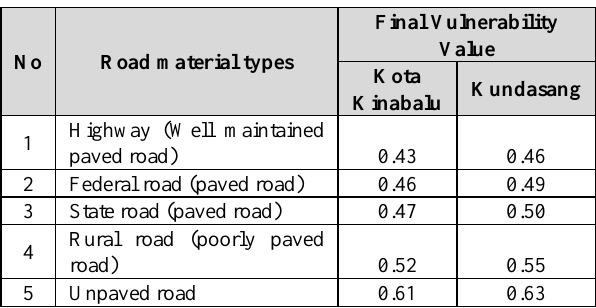
Table 14. Final vulnerability value for roads in Kota Kinabalu Based on derived vulnerability value of element-at-risk i.e.